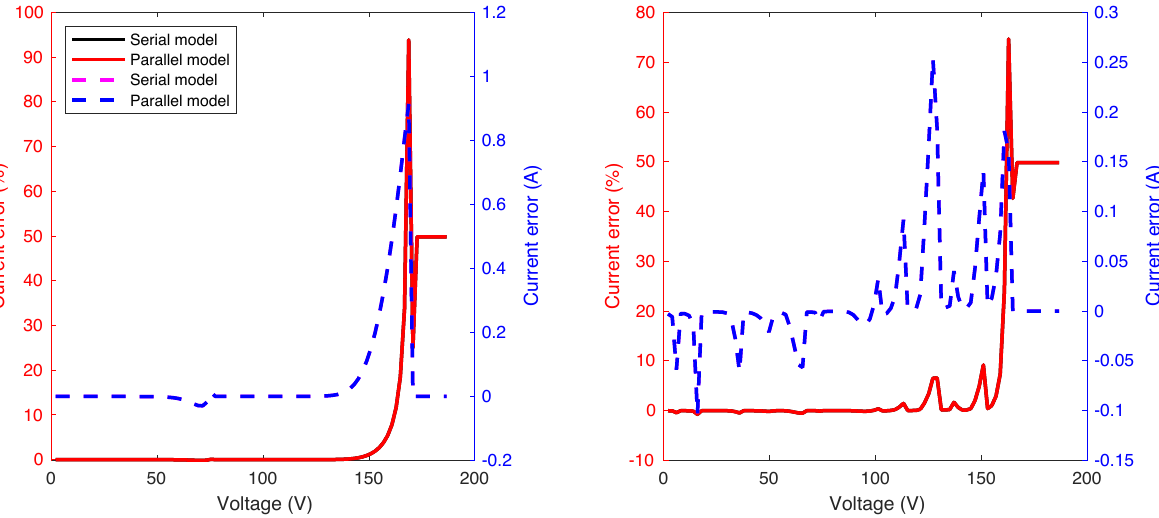
Figure 5. Current errors in A and % for a 15 × 2 array under two different partial shading conditions. ( Left ): current errors for condition C 1. ( Right ): current errors for condition C